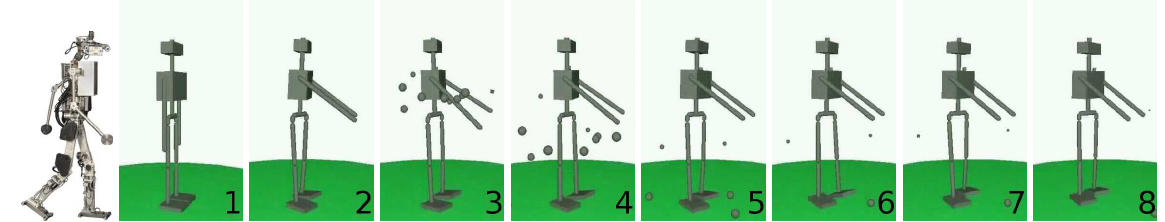
Figure 3. The original Johnnie (left). From left to right, a typical solution which worked well in the robust standing task is shown: 1. Initial posture. 2. Stable posture. 3. Perturbation by heavy weights that are thrown randomly at the robot. 4. - 7. Backsteps right, left, right, left. 8. Stable posture regained.